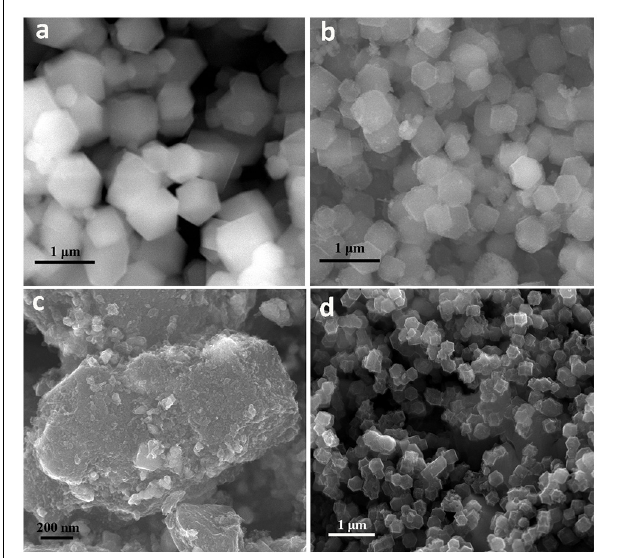
FIGURE 2 | Scanning electron microscope images of (a) Zn/Co/Fe-MOF precursor, (b) the products after sulfuration, (c) the final